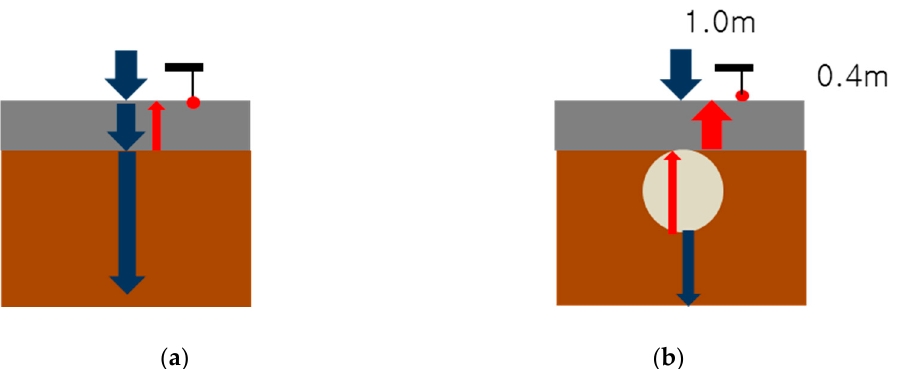
Figure 2. Schematic of generating and measuring reflected waves by impact loading: ( a ) without gap, ( b ) with gap.